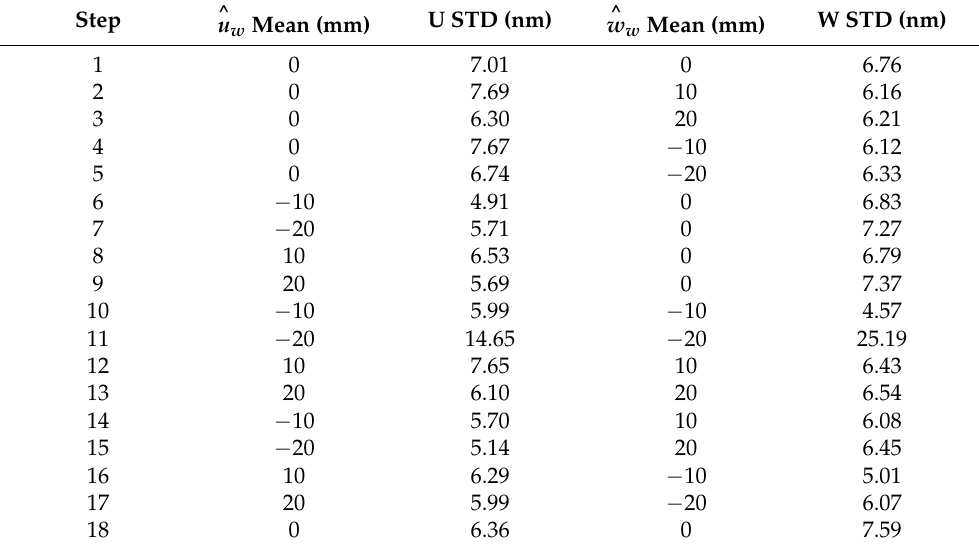
Table A2. Mean and standard deviation of the imposed displacements measured by the stage’s optical encoder for Sample 1